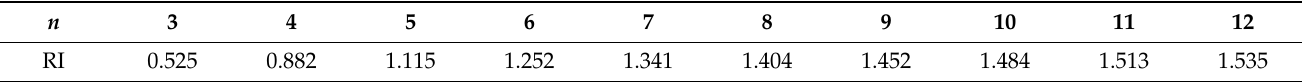
Table 2. The values of the RI corresponding to a variety of n .